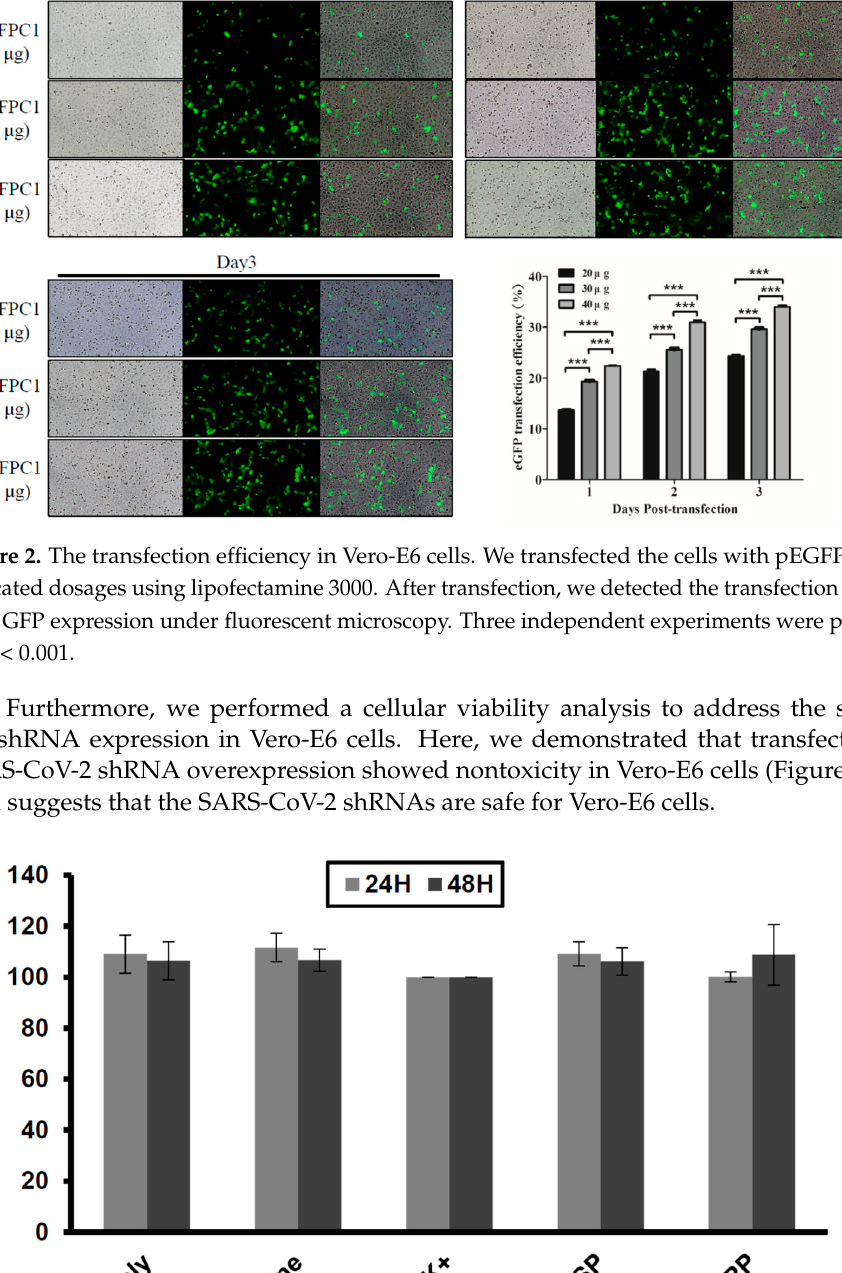
5 of 10 Figure 1. Conservation of targeting of shCoV2019SP and shCoV2019RdRP among different variants of SARS-CoV-2. 3.2. ShRNA against SARS-CoV-2 Is Nontoxic in Vero-E6 Cells To evaluate the inhibitory effects of shRNA constructions in SARS-CoV-2, we inves- tigated the plasmid transfection efficiency with a reporter plasmid, pEGFPC1. We trans-